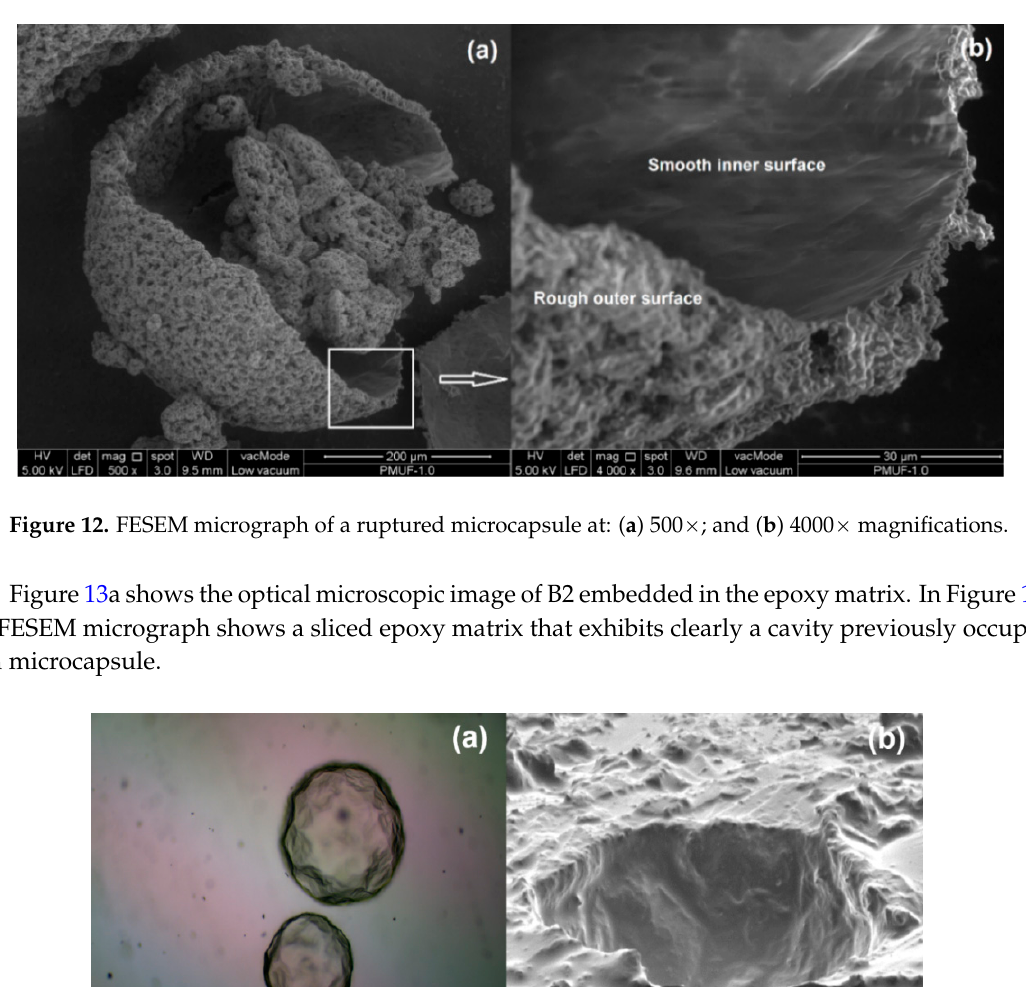
micrograph of a sliced epoxy matrix showing a cavity previously occupied by a microcapsule.